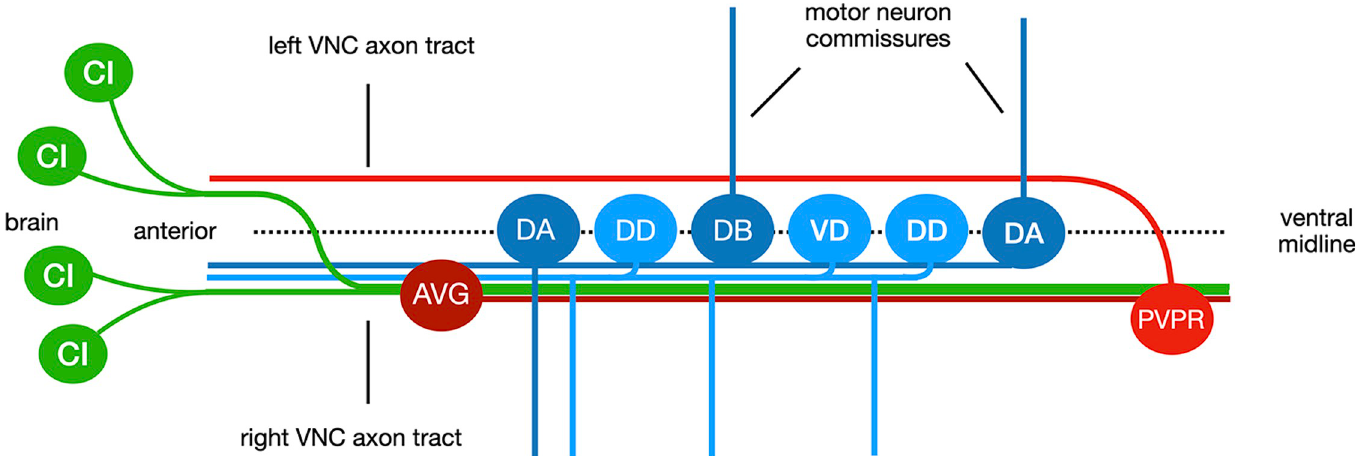
Fig 1. The ventral nerve cord. This schematic displays some of the neurons that send axons into the VNC. The AVG neuron cell body is located at the anterior end of the VNC. Its axon pioneers the right axon tract. The PVPR axon pioneers the left VNC axon tract, extending from the tail region in the anterior direction. Motoneuron cell bodies (DA, DB, VD and DD) are located between the two tracts of the VNC. They send neurites into the right tract, and commissures dorsally either on the left or the right side in an invariant pattern. Command interneurons (CI) extend axons from their cell bodies in the brain into the VNC. Axons entering from the left side cross into the right axon tract at the anterior end of the